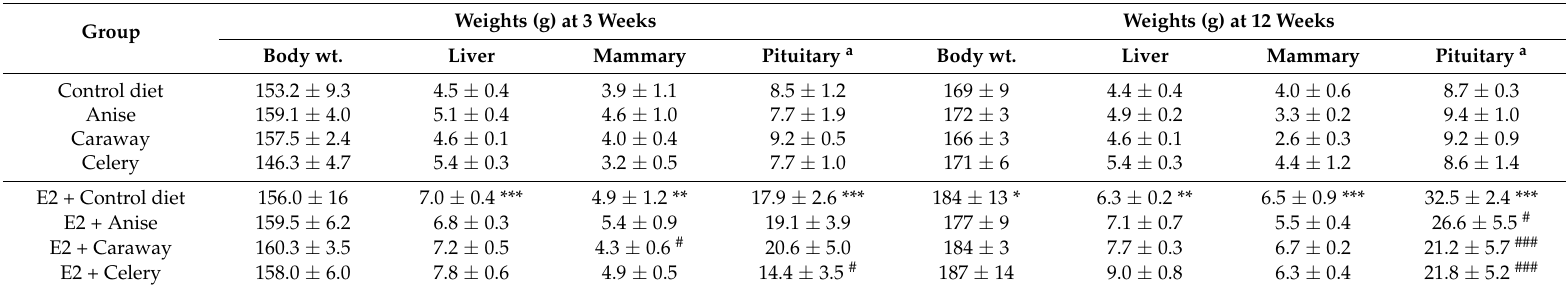
Table 1. Animal body and organ weights after 3 and 12 weeks of